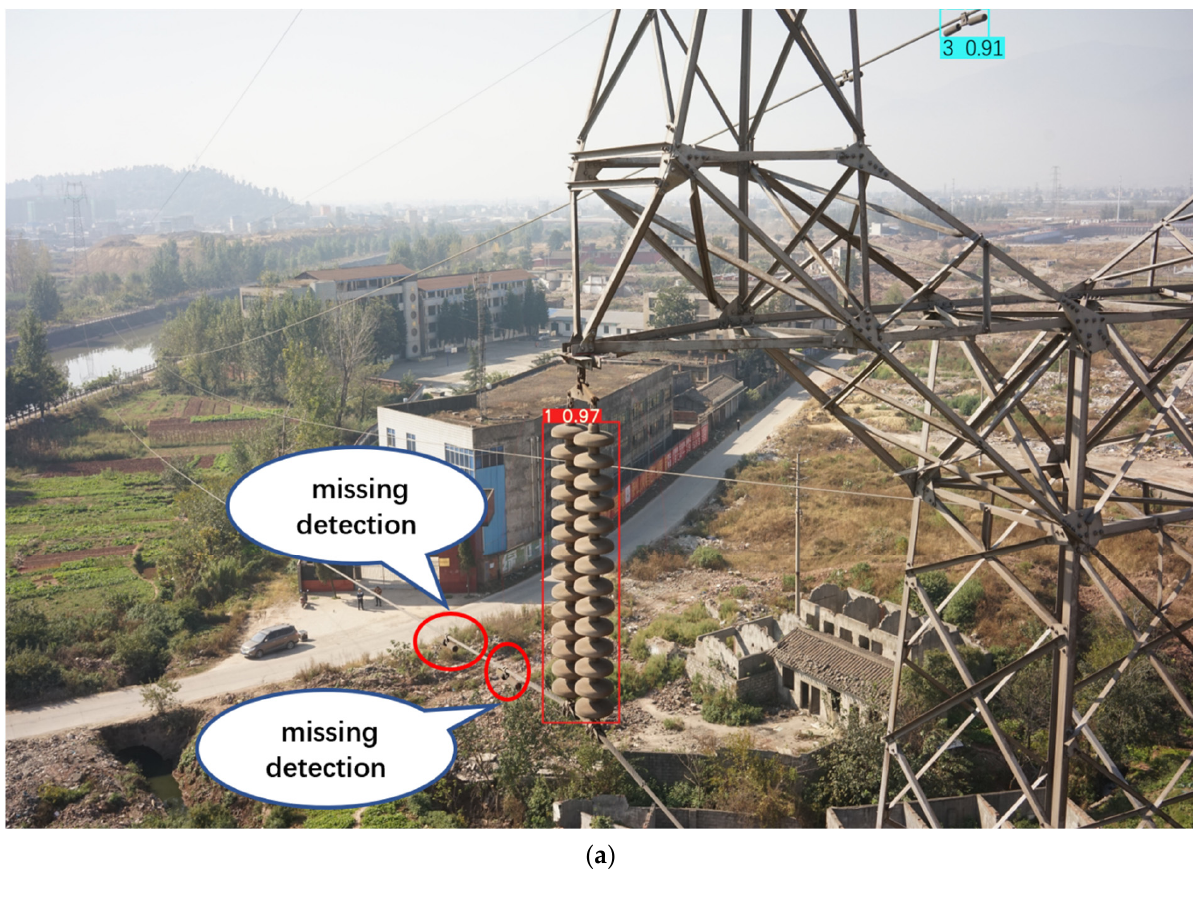
Figure 16. Confusion matrix.